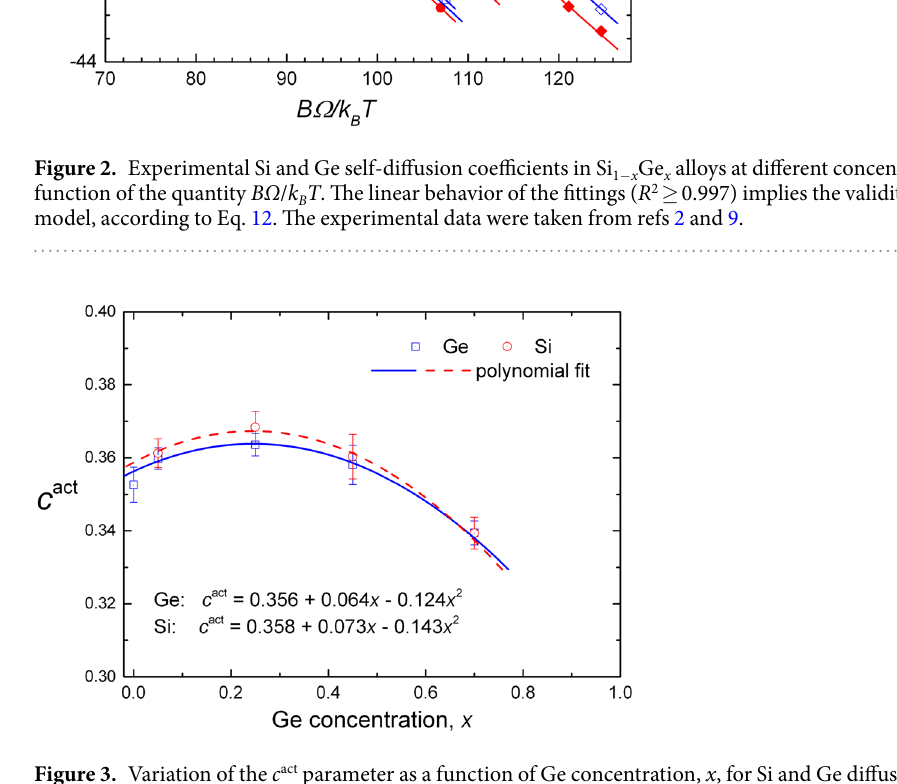
Figure 3. Variation of the c act parameter as a function of Ge concentration, x , for Si and Ge diffusion in Si 1 − x Ge x alloys. In both cases, the data were fitted sufficiently with a 2 nd order polynomial ( R 2 ≈